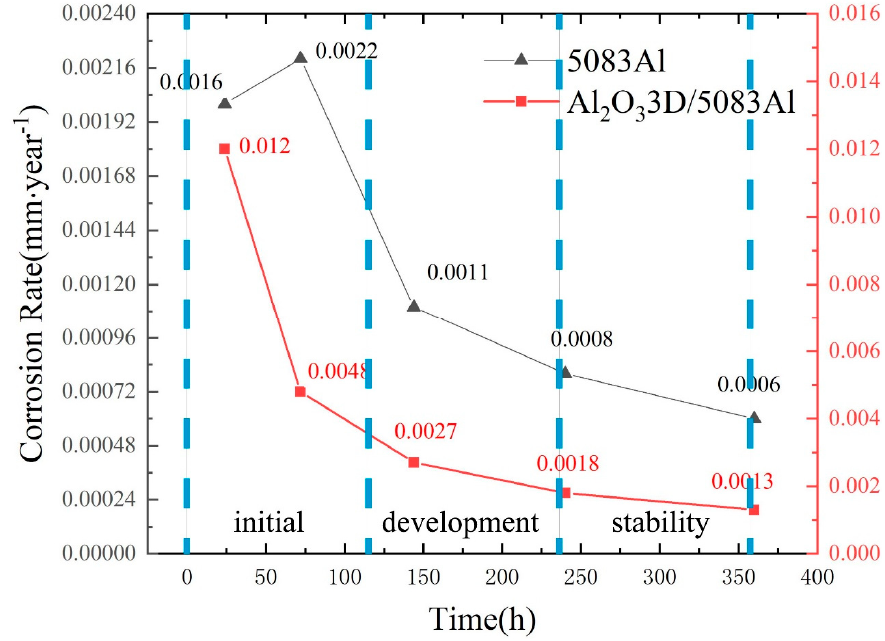
Figure 12. Corrosion rate (CR) of the two materials vs. NSS time.